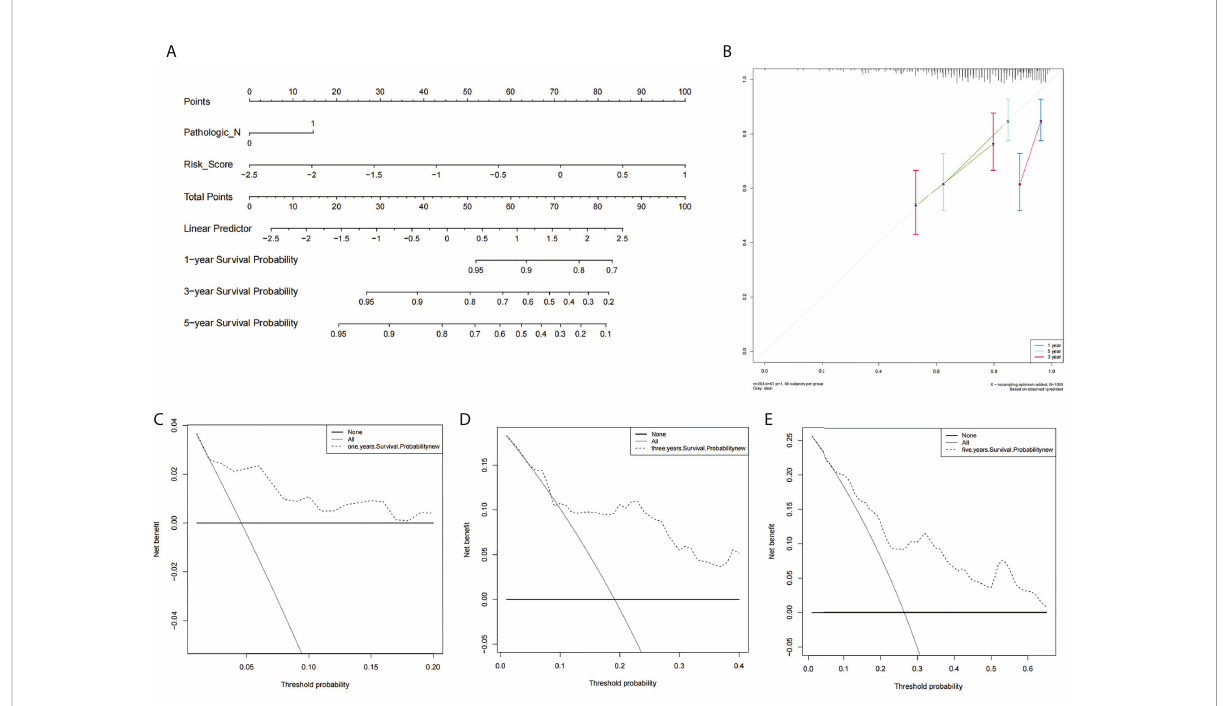
FIGURE 5 The prognostic assessment models in accordance with two lncRNAs related to the necroptosis. (A) The nomogram which consisted of 1-, 3-, and 5-year OS on the basis of the Pathologic_N stage and risk score. (B) The nomogram which predicted the probability of 1-, 3-, or 5-year survival and the calibration plots which were utilized to estimate the consistency between the predictions of the prognostic models and the actual OS. The 45° reference line expresses ideal calibration, in which the predicted probabilities are in accordance with the realistic probabilities. The decision curve analysis (DCA) of 1-year (C) , 3-year (D) , and 5-year (E) overall